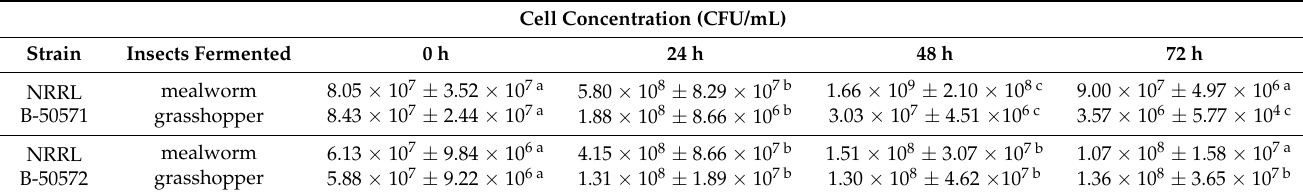
Table 4. The cell concentration of L. lactis strains during the fermentation processes of edible insect flour. Cell Concentration (CFU/mL)